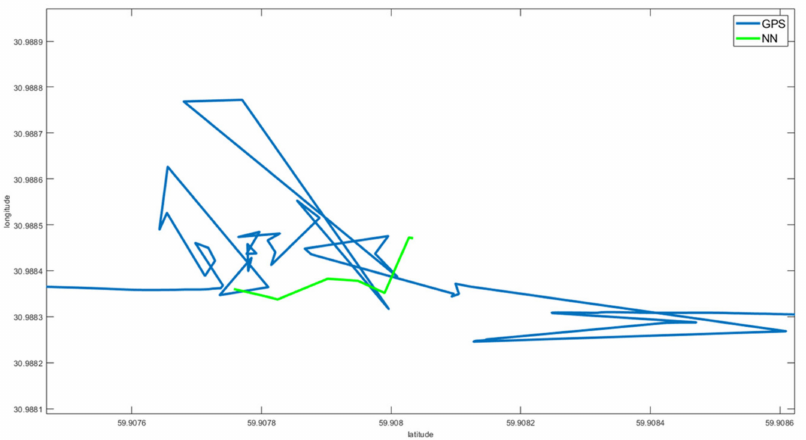
Figure 9. Comparison of the trajectory predicted by the neural network with the reference trajectory along the path with data loss and